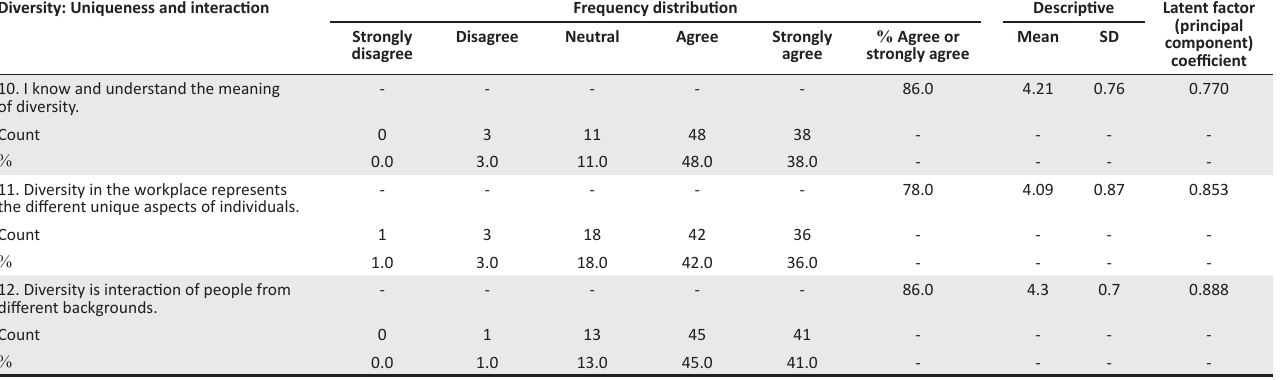
TABLE 3: Analysis of the sub-construct of uniqueness and interaction. Diversity: Uniqueness and interaction